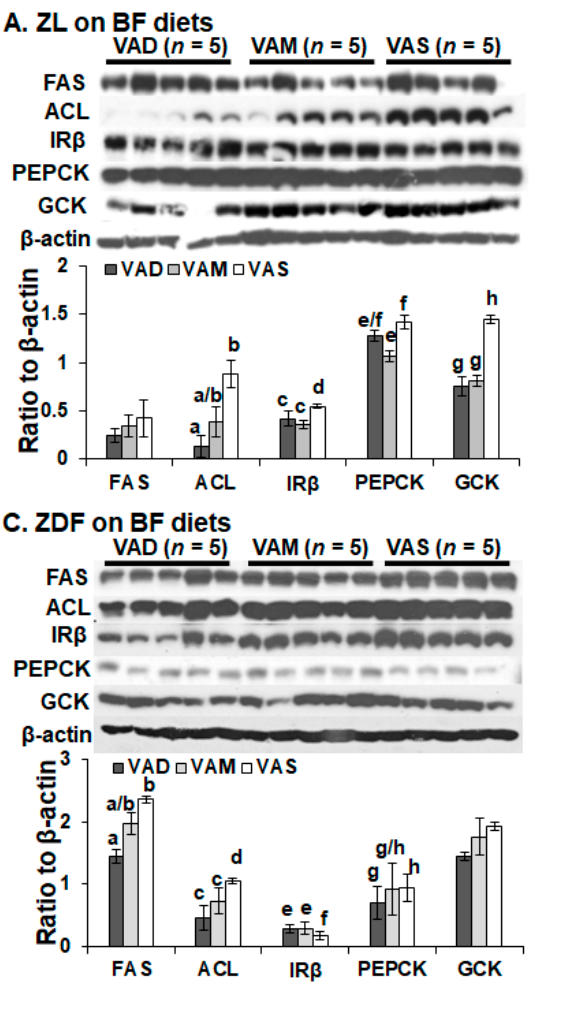
Figure 9. The hepatic levels of FAS, ACL, IR β , PEPCK, and GCK in ZL (A,B) and ZDF (C,D) rats fed a VAD, VAM or VAS diet with BF (A,C) or HF (B,D) content for 8 weeks. Proteins (60 µ g/well) in whole tissue lysates were separated and analyzed using Western blot analysis. The ImageJ Software was used to determine the densitometry of the indicated protein band. The results are presented as means ± SEM of the ratio of the indicated protein to β -actin (n = 5–6 per group). (A) a < b, c < d, e < f, and g < h for comparing the groups in the same fat content and genotype; (B) a < c < b, and e < d; (C) a < b, c < d, f < e, and g < h; (D) a < b, c < d, f < e, g < h < i for comparing the groups in the same fat content and genotype using one-way ANOVA; all p < 0.05.